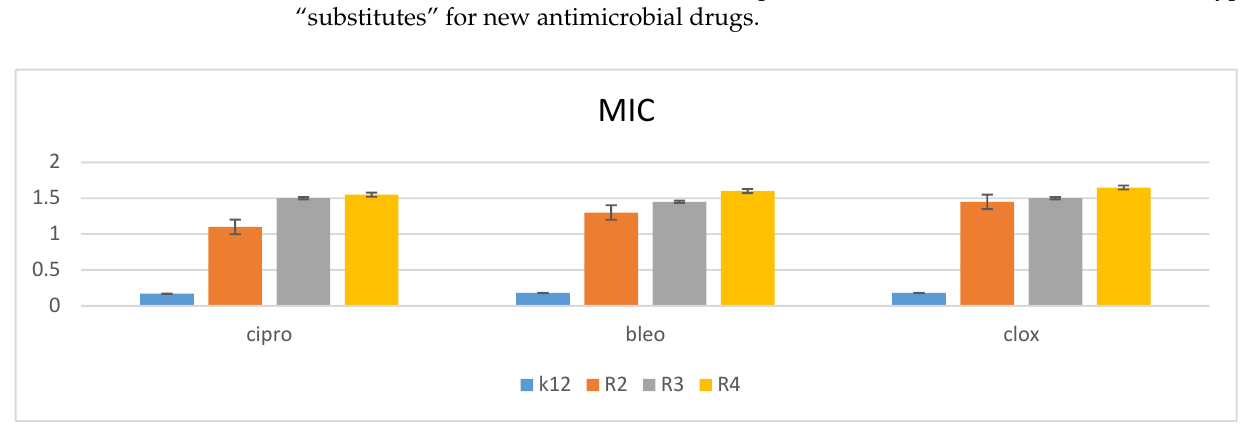
Figure 8. Examples of MIC with model bacterial strains K12, R2, R3, and R4 for studying antibiotics ciprofloxacin (cipro), bleomycin (bleo), and cloxacillin (clox). The x -axis features antibiotics used sequentially. The y -axis features the MIC value in µg/mL. The order in which the compounds were applied to the plate are shown in Supplementary Materials Figure S1.